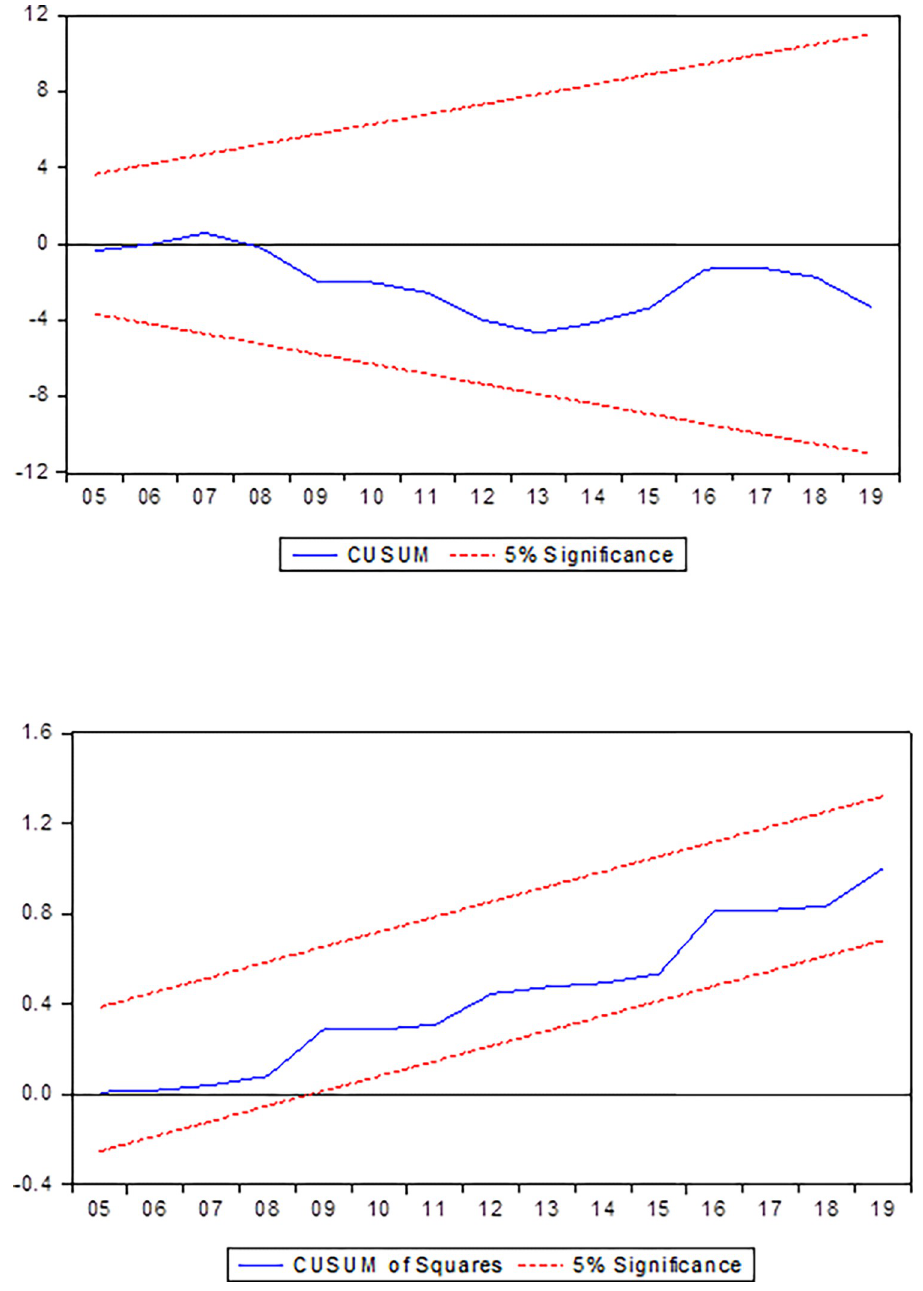
Fig 2. CUSUM and CUSUM square estimates. Source: Author’s